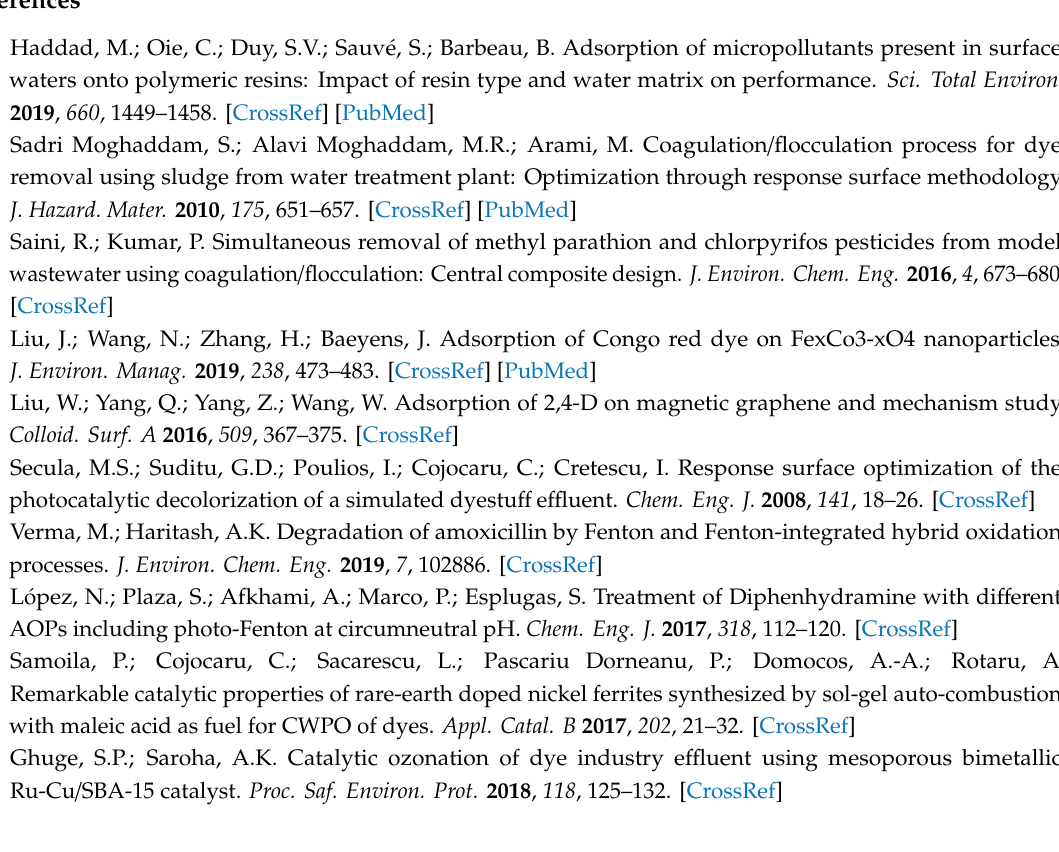
Table S1: ANOVA test for the fitted model; Table S2: ANOVA test for the fitted model; Table S3: ANOVA test for the fitted model; Table S4: ANOVA test for the fitted model; Figure S1: Nitrogen adsorption–desorption isotherms, and corresponding BJH pore size distributions (calculated from adsorption and desorption branches, respectively); Figure S2: SEM images for the synthesized TiO 2 nanoparticles—M4 and M5 samples; Figure S3: UVDR-derived Tauc indirect plots for the synthesized TiO 2 nanoparticles—M4 and M5 samples, and determined band gap energies; Figure S4: FTIR spectra of synthesized TiO 2 nanoparticles—M4 and M5